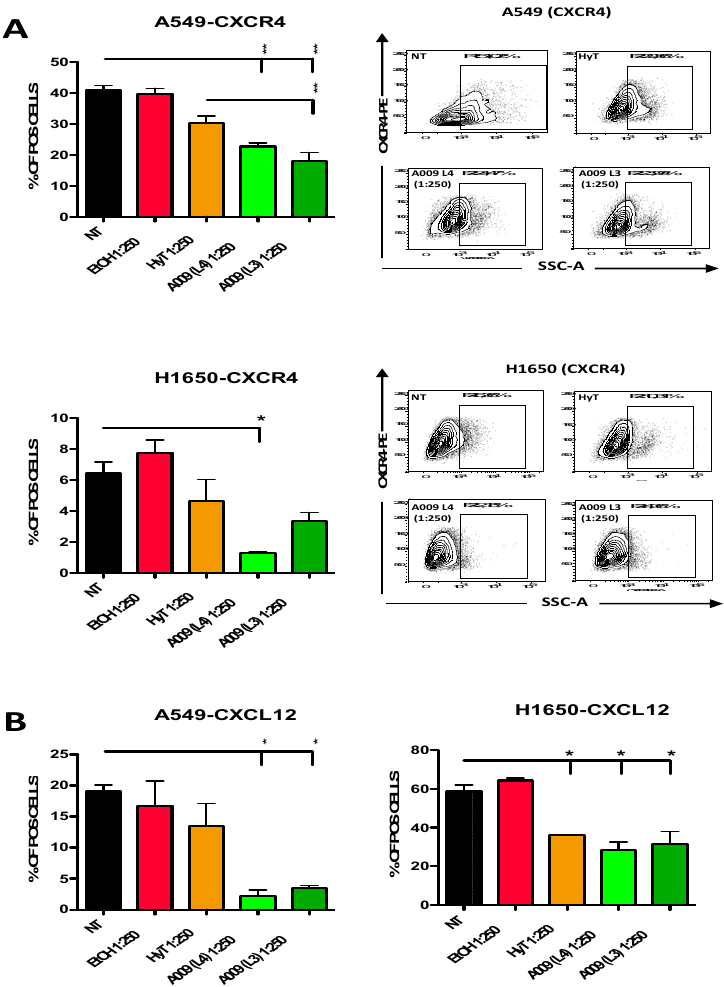
Figure 5. Effect of the A009 extracts on the CXCR4/CXCL12 axis in lung cancer cells in vitro. The A549 and H1650 lung cancer cells were treated for 6 hours with 2 different batches of A009 (L4 and L3), at the dilutions 1: 250 or with hydroxytytosol (HyT) at the same concentration present in the dilutions of A009. Protein secretion was stimulated with a cocktail containing BrefeldinA and Monensin + Ionomycin and Forbol 12-meristate, 13-acetate. After 6 hours of stimulation, cells were analyzed for CXCR4 (A), CXCL12 (B) expression, by flow cytometry. Representative dot plots for CXCR4 surface detection are showed (A). Flow data were analyzed using FlowLogic software. Results are shown as mean ± SEM, One Way ANOVA, * p < 0.5, ** p < 0.01. NT (untreated); EtOH (ethanol vehicle used to dissolve hydroxytyrosol).